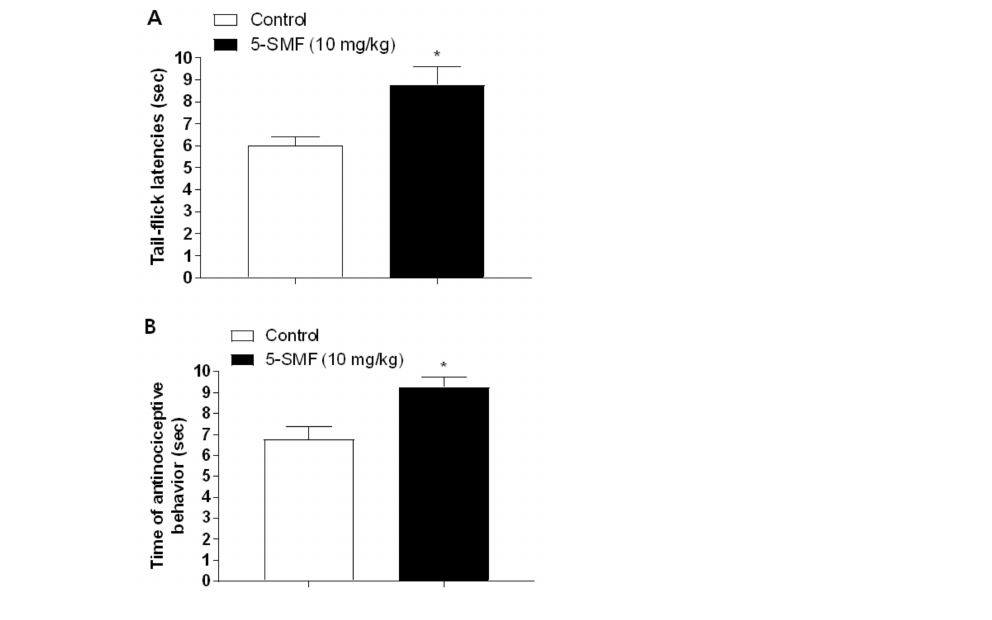
Figure 15. Effect of 5-SMF and gabapentin in the tail-flick test ( A ) and hot-plate tests ( B ). Data are